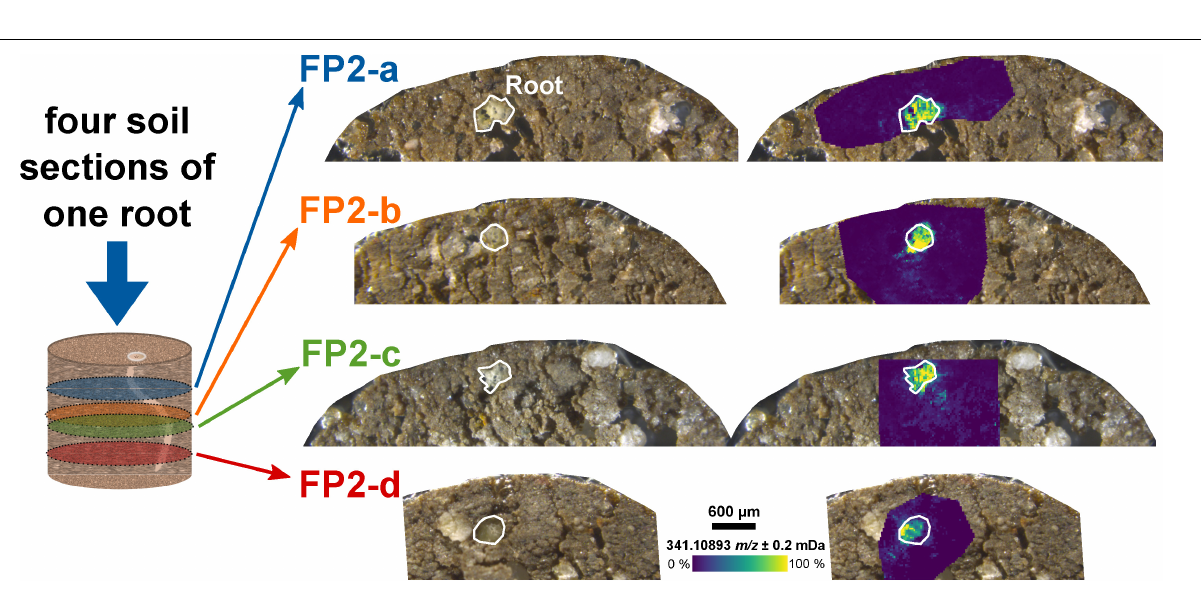
Frontiers in Plant Science |